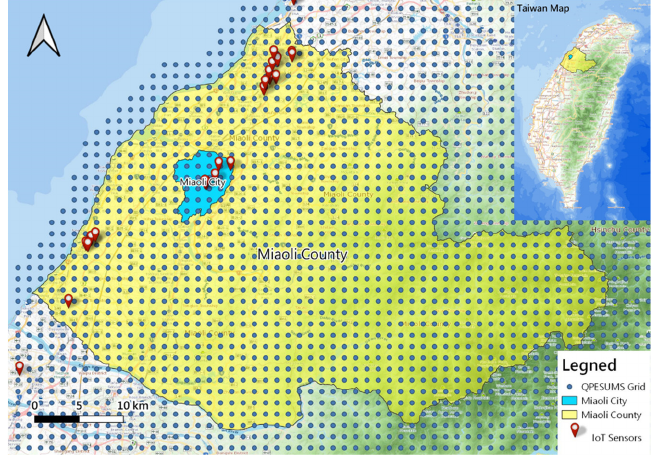
Figure 5. Location of Miaoli County (note: blue circles are the radar-precipitation grid, and red points are the roadside IoT sensors).